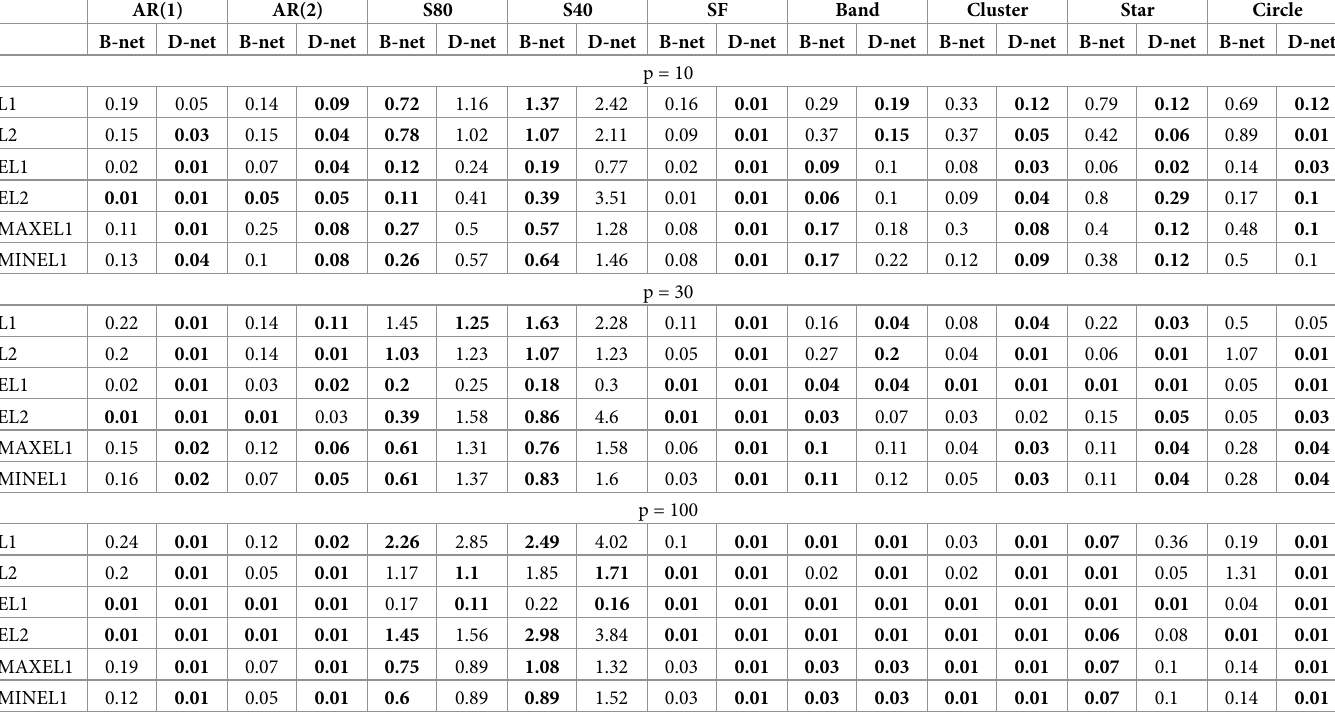
Table 3. Synthetic study standard error loss results.